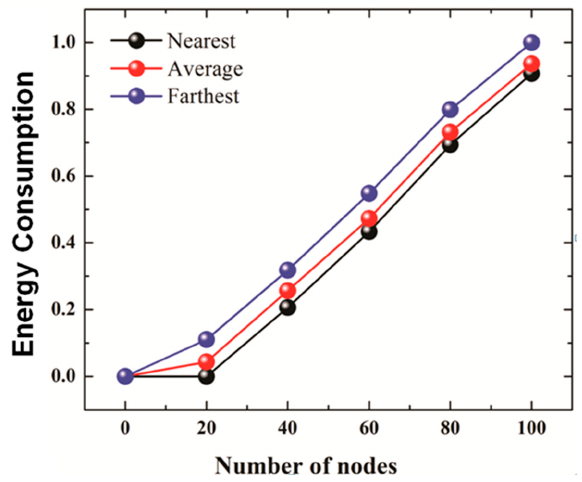
Figure 12. Energy Consumption for different CH positions. Sensors 2019 , 19 , x FOR PEER REVIEW